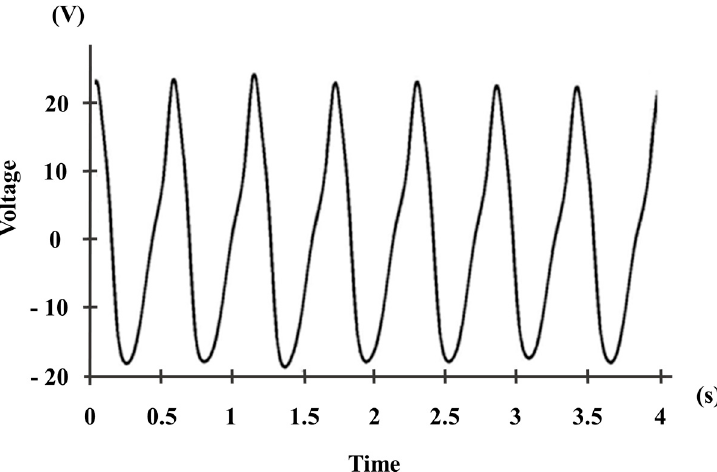
Figure 4. Sample of the signal of the voltage output measured by using the LDT4-028k transducer placed on the elbow joint for the movement of flexion-extension. The calculated RMS value corresponds to 13.78 V, slightly less than the value that could have been obtained if Equation (6), for sinusoidal waves, had been applied (14.62 V).